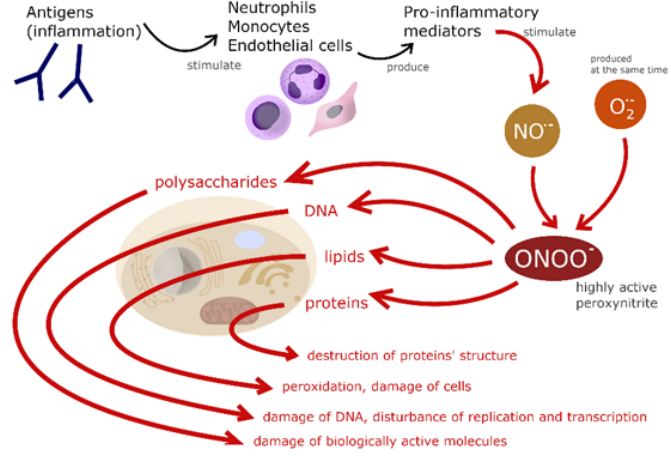
Figure 1. Reaction paths of ROS and RFN during oxidative stress and the negative effects of it.